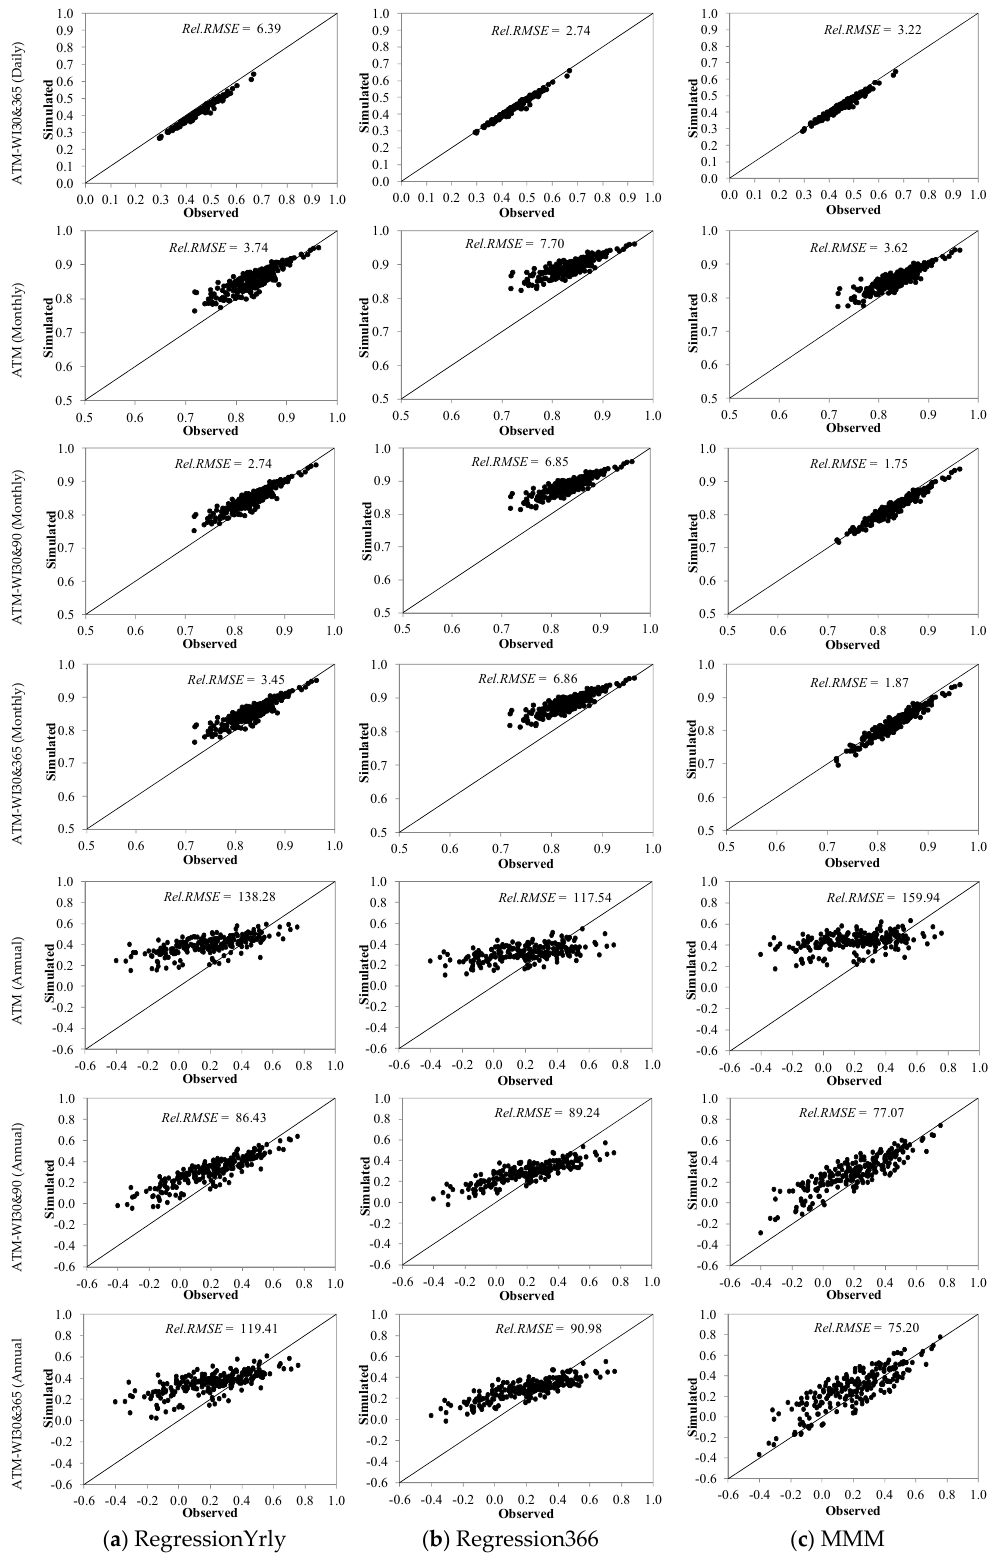
Figure 8. Scatter plots of observed and models simulated daily, monthly and annual cross correlations using multisite model (Calibration period). Rel. RMSE values are shown on the top right of each plot: ( a ) using RegressionYrly model; ( b ) using Regression366 model; and ( c ) using